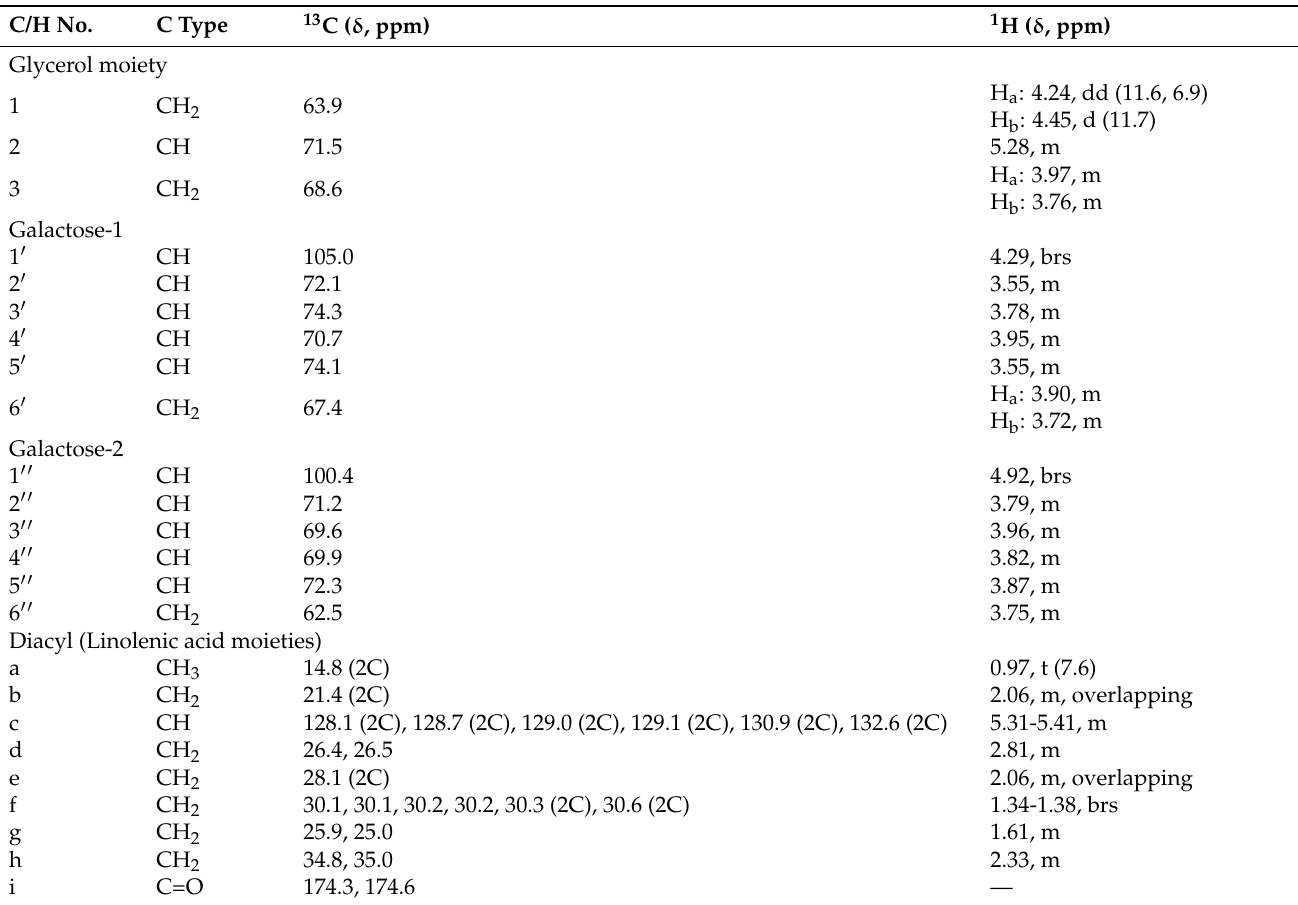
Figure 3. HSQC expansions (4.10–5.10 ppm) of; ( a ) compound 1 and ( b ) compound 2 in CD 3 OD; and 1 H NMR expansions of; ( c ) compound 1 ( δ H 4.60–4.78) and d) compound 2 ( δ H 4.56–4.82) in DMSO- d 6 , revealing the splitting patterns and coupling constant “ J ” values (Hz) for the anomeric protons of galactose moieties, H-1 ′ and H-1 ′′ in both solvents.